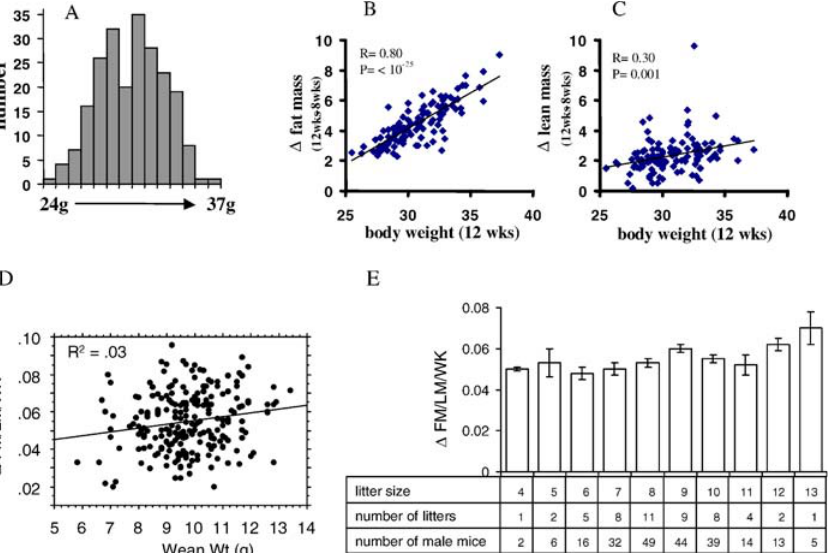
Figure 1. Establishing Variations in Adiposity in Diet-Induced Obesity in Male C57BL/6J Mice Frequency distribution of body weight in 219 mice at 12 wk of age, after being fed a high-fat diet for 4 wk. (A) Regression analysis between the change in body weight and fat mass (B) and change in body weight and lean body mass (C) from 8 and 12 wk of age as determined by NMR in 112 mice. (D) Regression analysis between mouse weight at weaning and the percent change of the ratio of fat mass (FM) to lean mass (LM) per week, p ¼ .0105, n ¼ 220. Changes in the FM/LM ratio per wk were calculated from 8–12 wk of age or from 8–14 wk of age. (E) Average percent change of the ratio of FM/LM per week for the various litter sizes, p ¼ .0406, n ¼ 220 (ANOVA). DOI: 10.1371/journal.pgen.0020081.g001